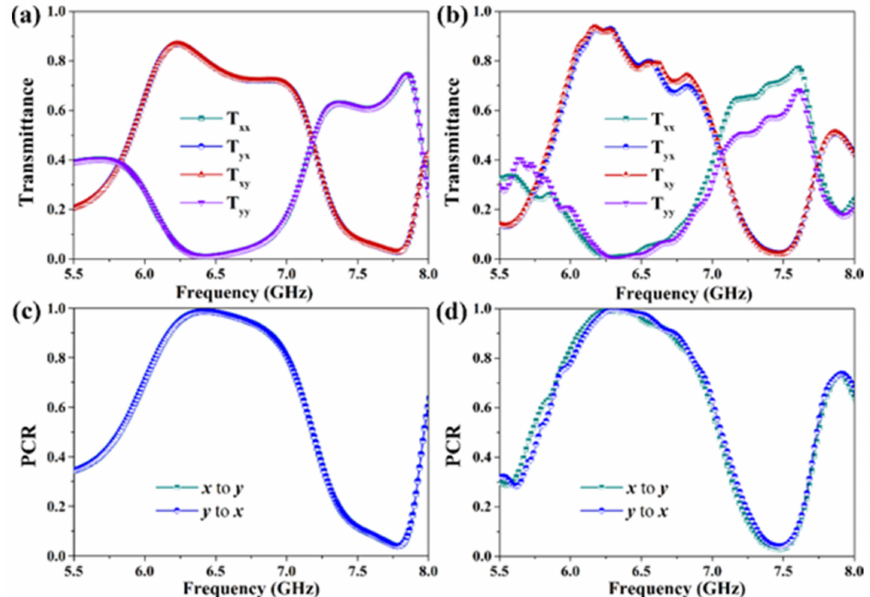
Figure 3. Simulated (left column) and measured (right column) results of the designed metagrating for the x - and y -polarized incident waves in transmission mode. ( a , b ) Transmittance, ( c , d ) PCR. Between 10.0 GHz and 15.0 GHz, the intriguing metagrating will operate in reflective